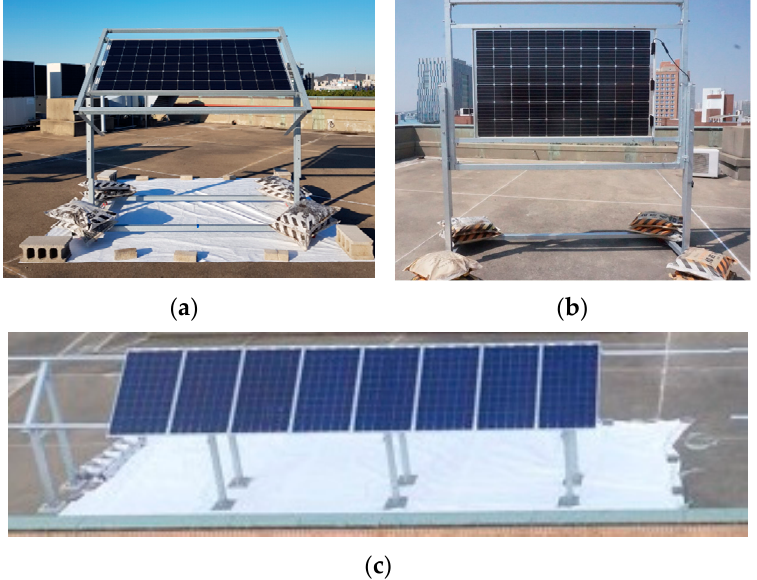
Figure 1. Installation set of testbeds: ( a ) installation set of Testbed 1; ( b ) installation set of Testbed 2; ( c ) installation set of Testbed 3.